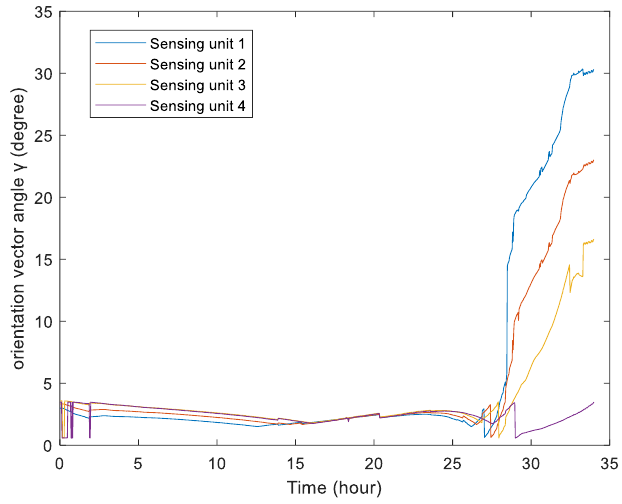
Figure 17. The curve of orientation vector angle.